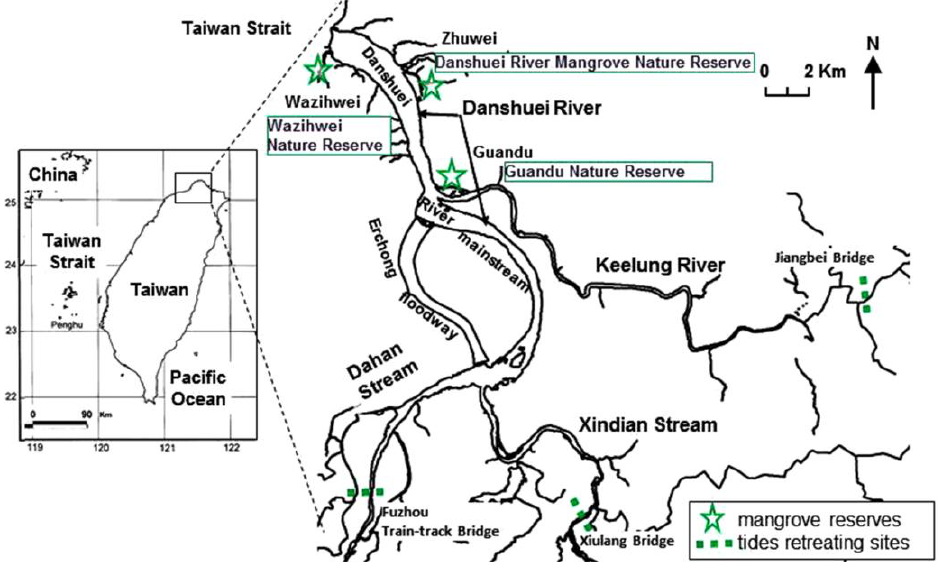
Figure 1. Map of the study area in the Danshuei River estuary. Asterisks: three mangrove reserves; dashed lines: sites where tides begin to